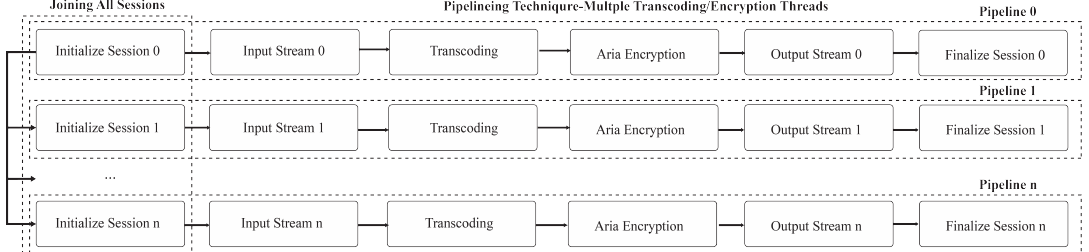
Figure 7. Transcoding and encryption for video streaming on multi-core